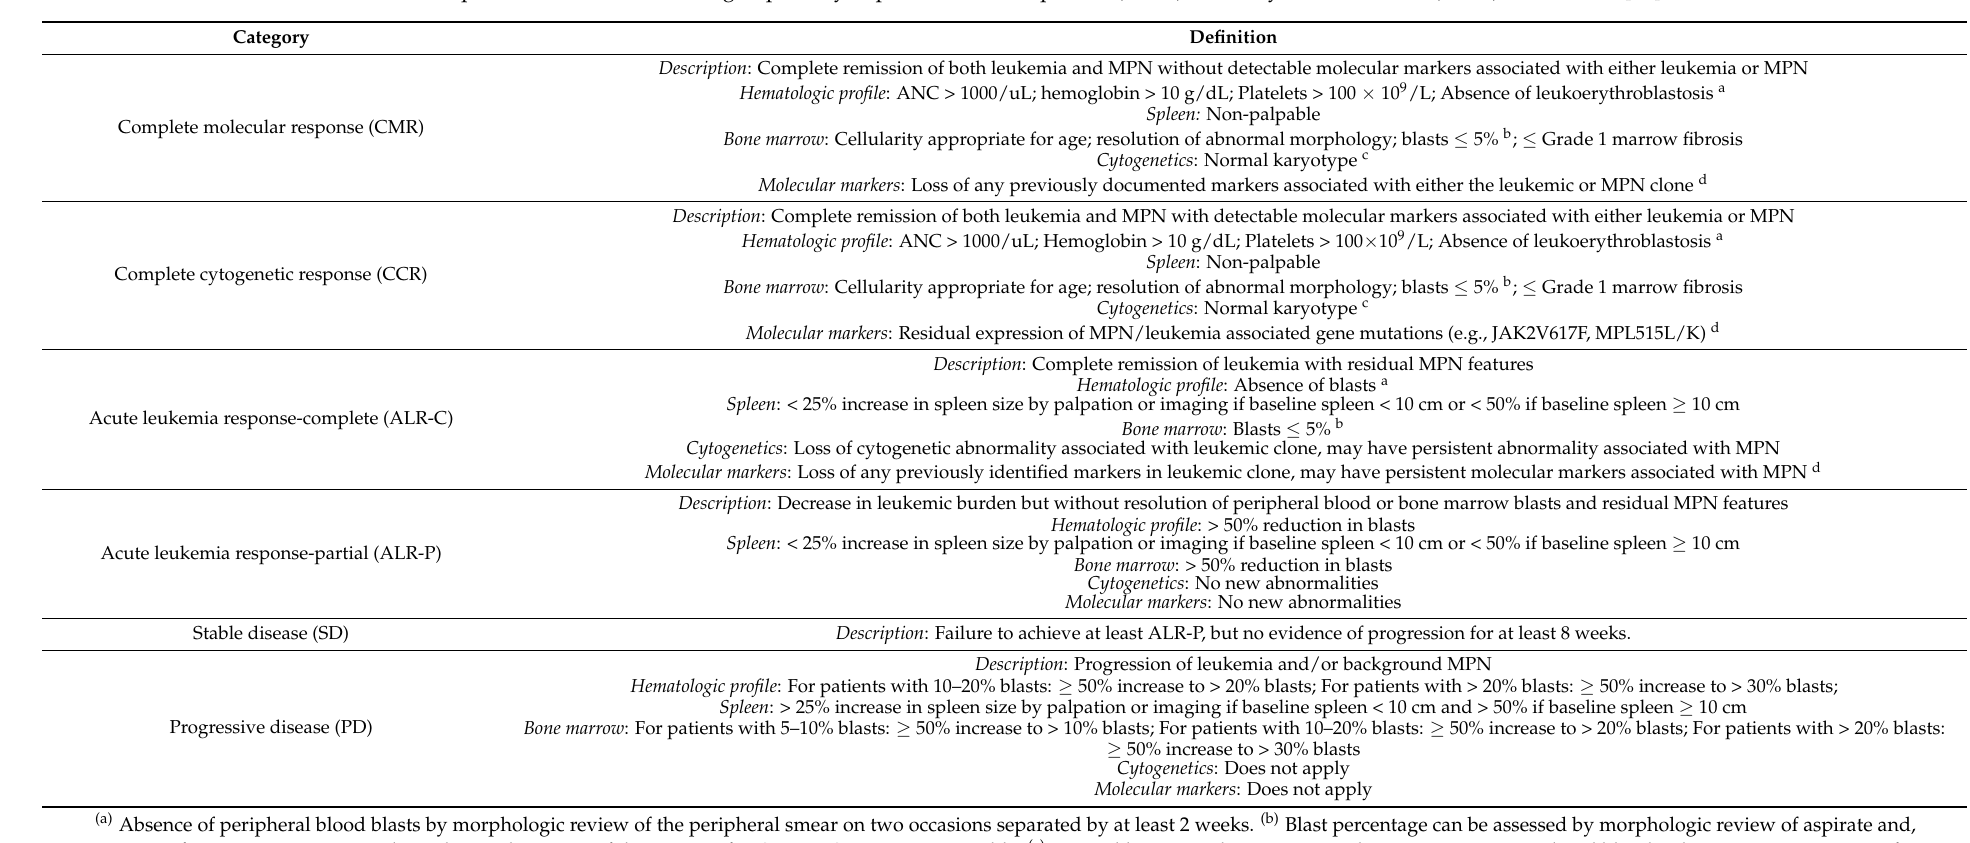
Table 1. Response definitions according to post myeloproliferative neoplasms (MPN) acute myeloid leukemia (AML) consortium